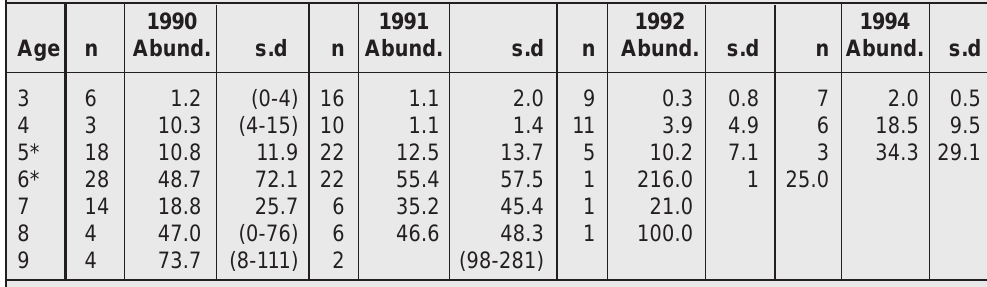
Table 3 . Abundance of P. decipiens in different age groups of sculpins sampled ay Vega from 1990 to 1994 . (